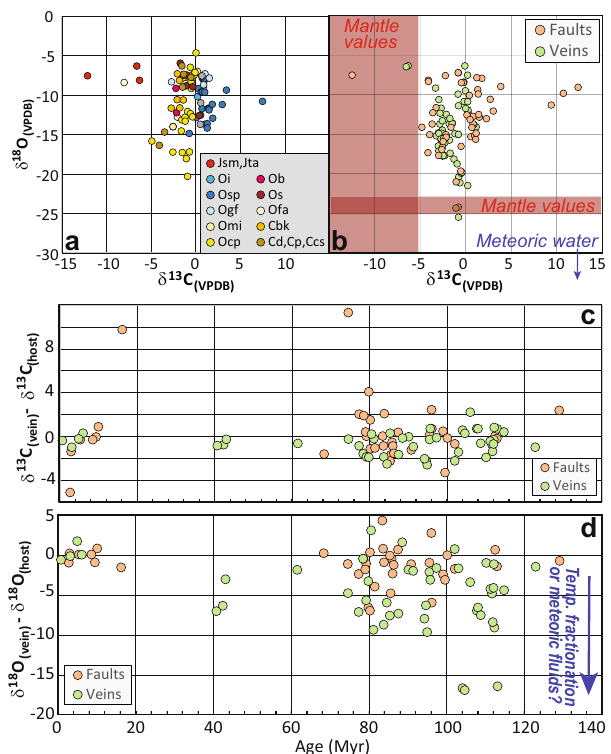
Fig. 3 Stable isotopes measured in calcite and host veins. a Stable isotope results for host rocks colored by rock type from Ratcliffe et al. 2011. Younger shale units (O sp , O i , and O gf ) show slightly heavier δ 13 C values then the older Ordovician carbonates (O mi , O cp , O b , O s , O fa , and O bk ). b Isotopic values of calcite from faults and veins, which appear to have crystallized from locally derived fl uids because they do not overlap published values for mantle fl uids or meteoric waters. c , d Difference between δ 13 C and δ 18 O measured in vein and host rock. Vein-host offsets in δ 18 O are consistent with temperature fractionation between fl uid and calcite. Particularly small offsets for Mio-Pliocene samples suggest calcite formed from locally derived fl uids at a low temperature and has not been